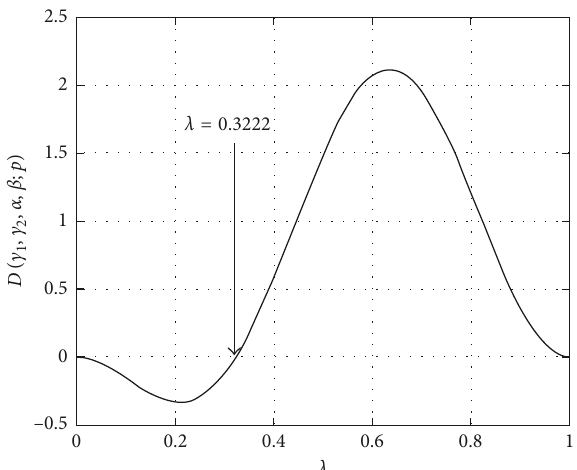
Figure 6: Calculated results of the characteristic equation.